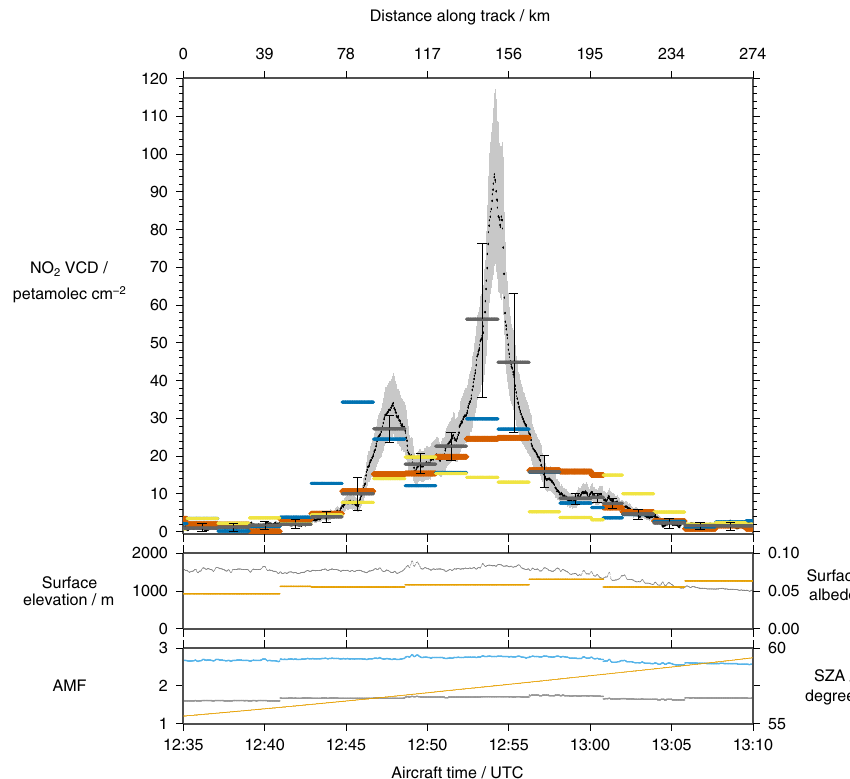
Figure 10. A time series of the airborne DOAS NO 2 vertical column densities on 9 August 2007, DOMINO V2.0 at aircraft nadir (orange) and one OMI line west (blue) and east (yellow) of aircraft nadir. Aircraft measurements averaged over the length of each OMI pixel are shown in grey, with 1 standard deviation in measured variability above and below the average indicated with error bars. Surface elevation (grey) and surface albedo (orange) are shown in the first sub-plot. The second sub-plot shows the minimum and maximum AMF estimates (grey and blue), and the solar zenith angle (orange) at aircraft time and